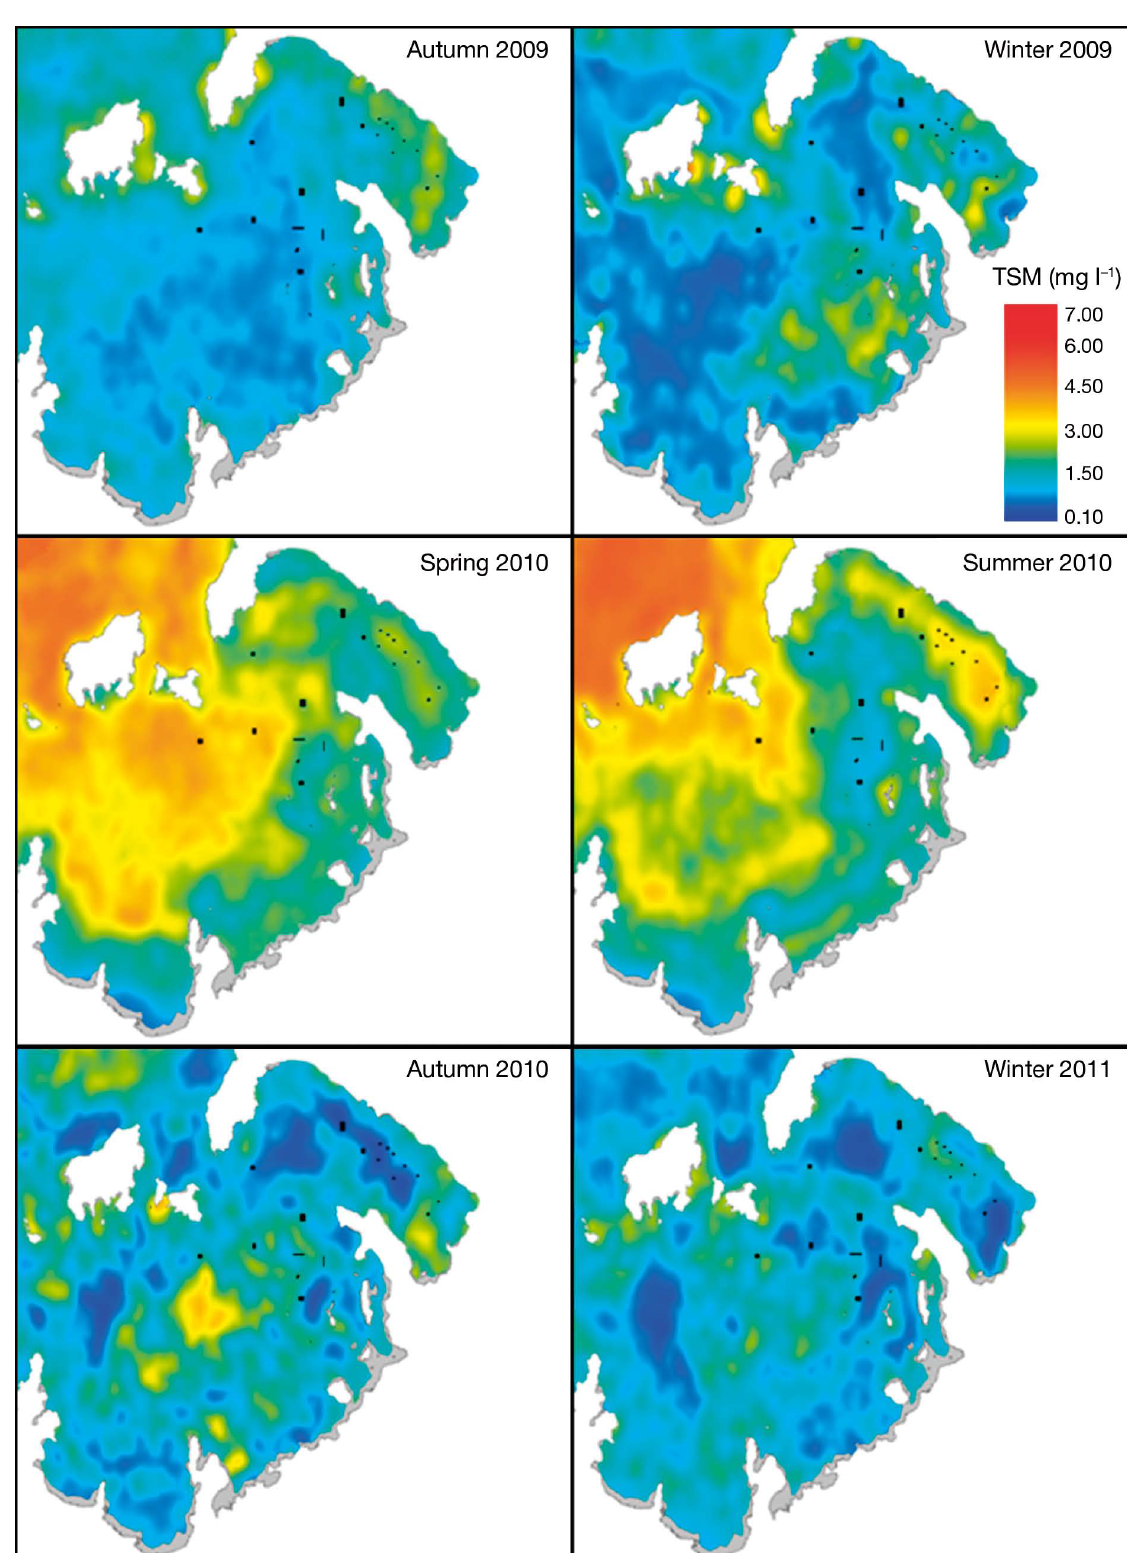
Fig. 4. Seasonal distribution of total suspended matter (TSM; black boxes show aquaculture areas, see Fig. 1) in Ildırı